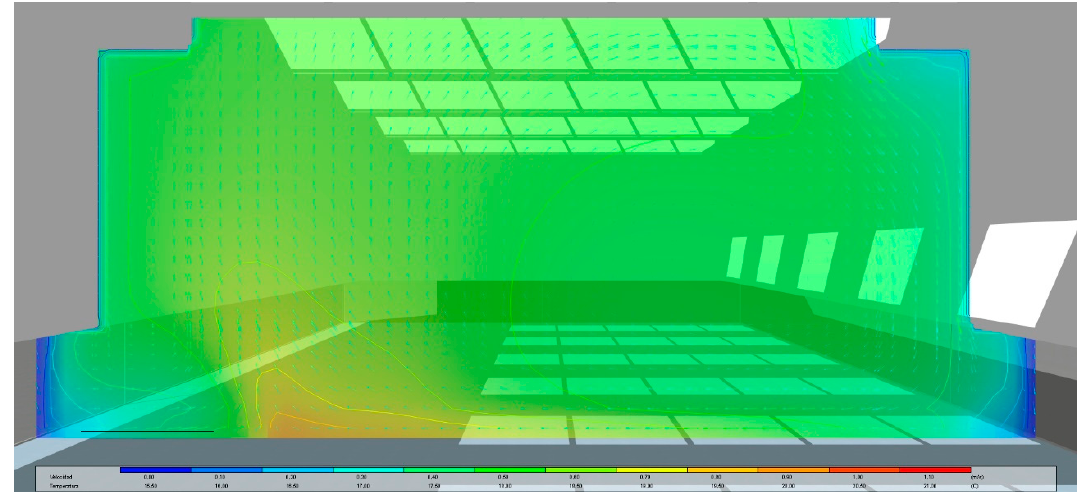
Figure 11. CFD graphic of the applied radiant floor system based on TCP panels. Cross section of the MUA. Indoor air temperatures. 1 February 2015. 9:00 a.m.